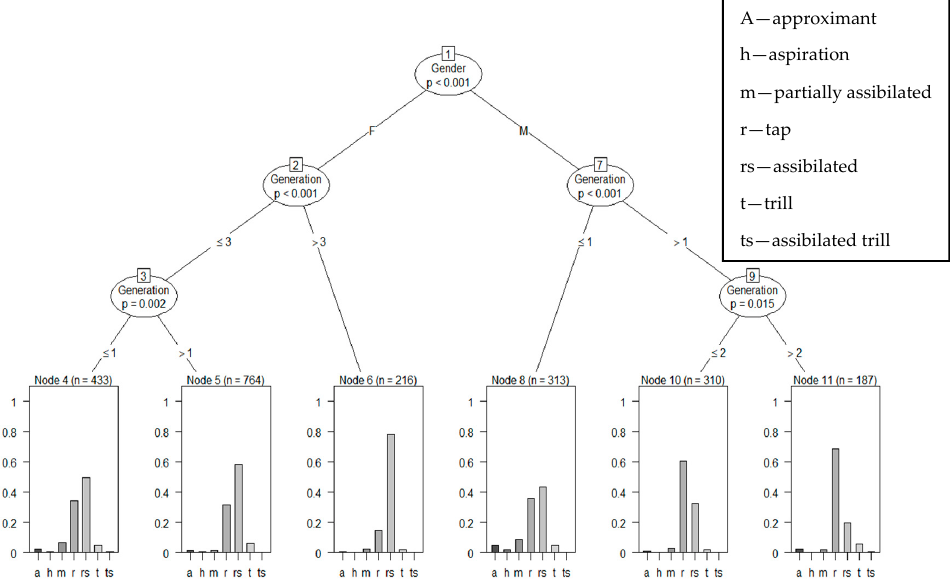
Figure 3. Conditional inference tree in R showing the distribution of phrase-final rhotic given gender and generation.